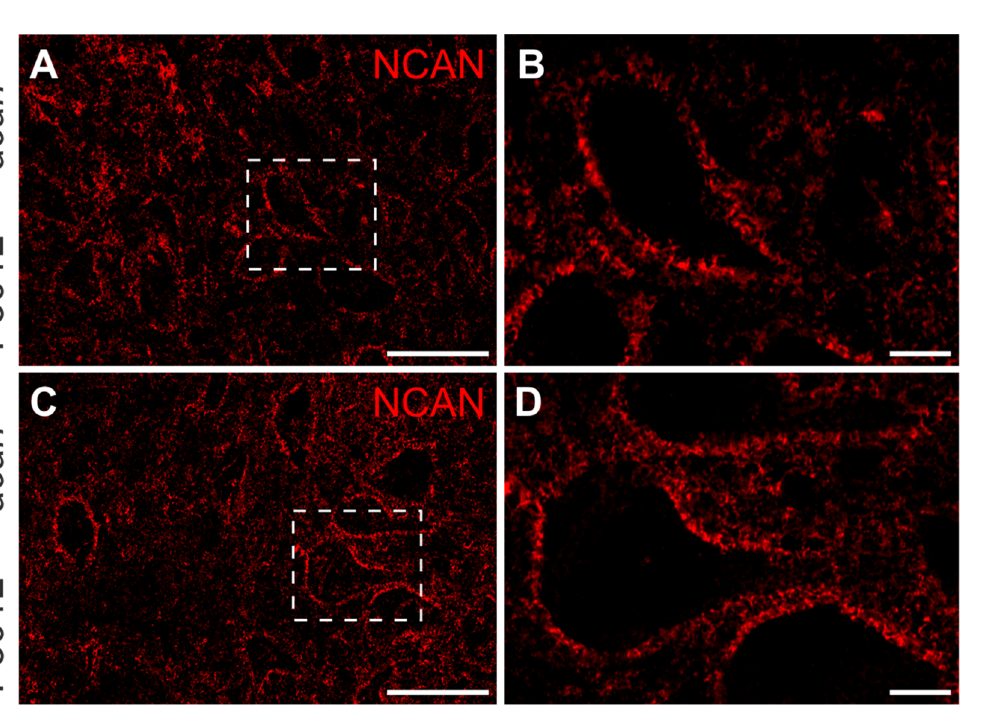
Figure 2. Characterization of neurocan in the Mo5 of TauP301L- acan mice. ( A – D ) Immunohisto- chemical analysis of neurocan (NCAN, AF5800 (R&D Systems)) in the motor trigeminal nucleus (Mo5) of 3 TauP301L HET - acan WT ( A , B ) and 3 TauP301L HET - acan HET mice ( C , D ). High magnification confocal images ( B , D ) of neurocan immunoreaction visualize location and structure of the immu- noreaction. Location and structure of the neurocan immunoreaction did not reveal any genotype- specific differences ( A , C ). Neurocan immunoreaction was exclusively detected extracellularly ( B , D ). ( E ) Western blot analysis of neurocan protein level (AF5800 (R&D Systems), at ~150 kDa) in the brainstem with a significant increase in TauP301L HET - acan HET mice compared to TauP301L HET - acan WT mice ( p = 0.001, TauP301L HET - acan WT n = 7, TauP301L HET - acan HET n = 8, t -test). Neurocan protein level was significantly increased in acan WT mice compared to TauP301L HET - acan WT mice ( p = 0.001, TauP301L HET - acan WT n = 7, acan WT n = 2, t -test). Mapt KO mice revealed a significantly increased neu- rocan protein amount compared to TauP301L HET - acan WT mice ( p = 0.049, TauP301L HET - acan WT n = 7, Mapt KO n = 3, t -test). For Western blot analysis protein extracts from homogenized brainstems of 7 TauP301L HET - acan WT , 8 TauP301L HET - acan HET , 2 acan WT , and 3 Mapt KO mice were used. Optical density (OD) of the specific chemoluminescence signal was quantified in relation to Coomassie stained total protein bands. Quantified areas on the Western blot lanes were marked by a bracket. For illustration